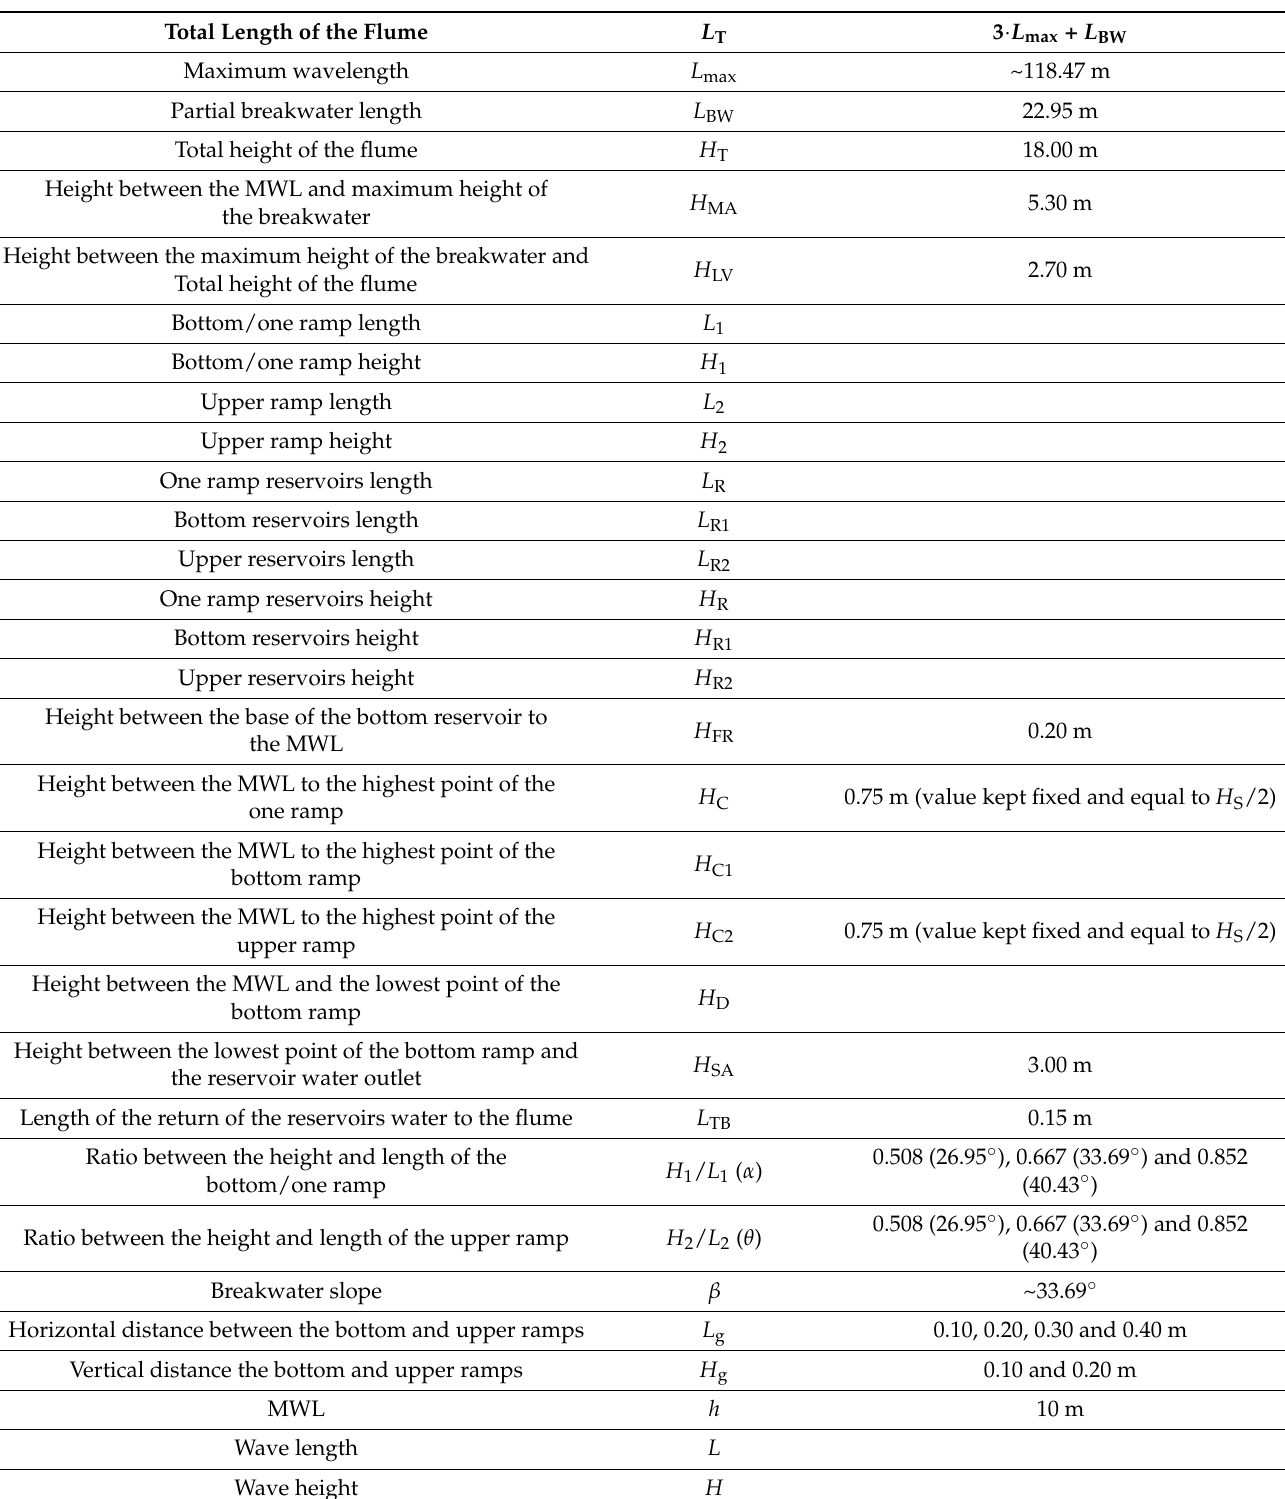
Table 1. Used dimensions of the computational